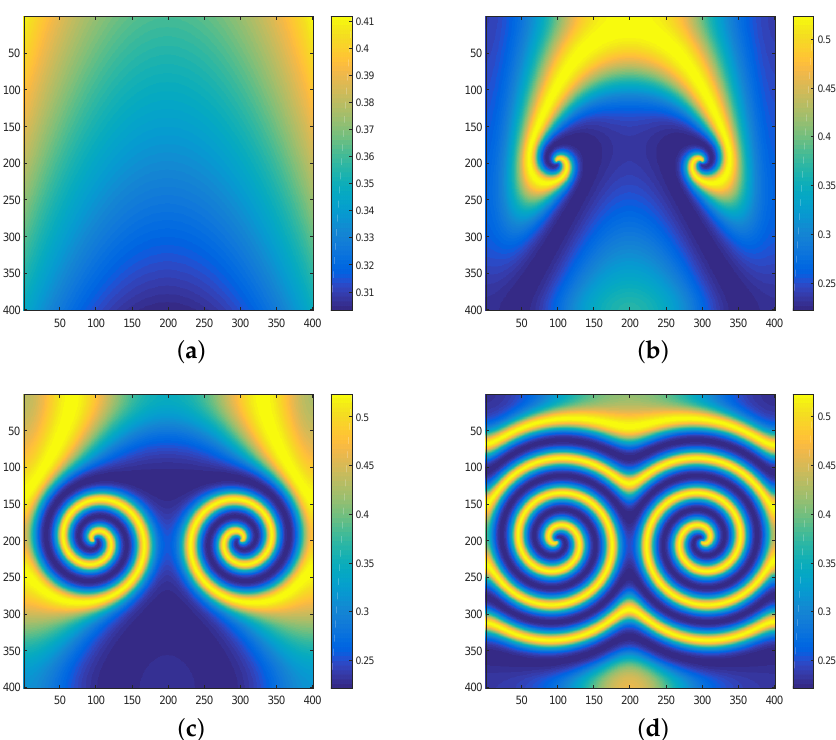
Figure 11. The spiral pattern evolution process of the model (3), the parameters are given by (41). Times: ( a ) t = 0, ( b ) t = 1000, ( c ) t = 5000, ( d ) t = 10,000.